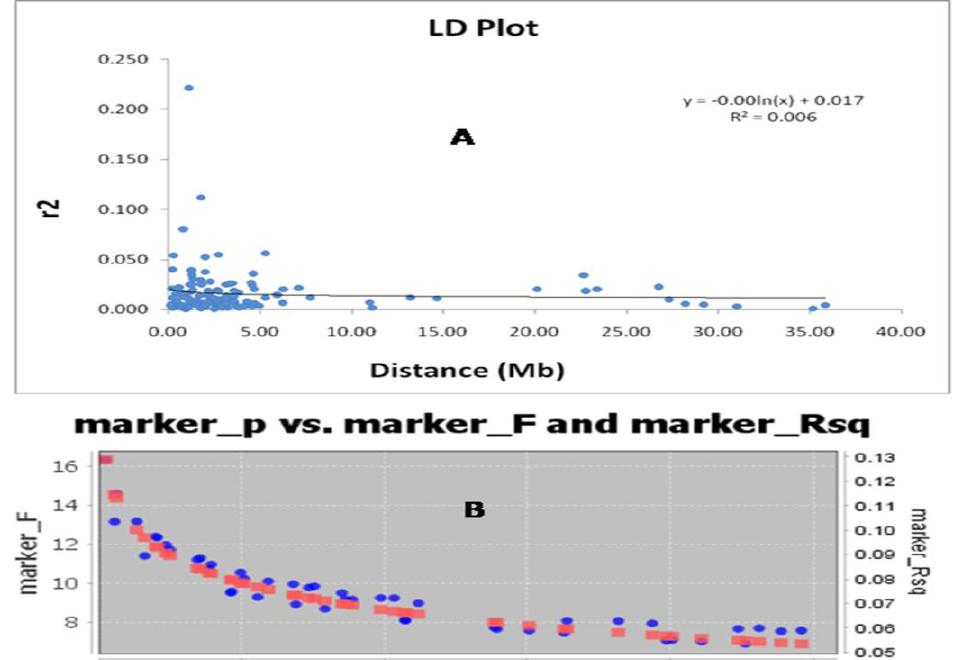
Figure 6. ( A ) The physical distance (megabase pairs, Mb) between pairs of loci on chromosomes against the linkage disequilibrium (LD) decay ( R 2 ) curve plotted in rice. The decay in million bp was estimated by taking the 95th percentile of the distribution of R 2 for all unlinked loci. ( B ) The marker ‘P’ versus marker ‘F’ and marker R 2.